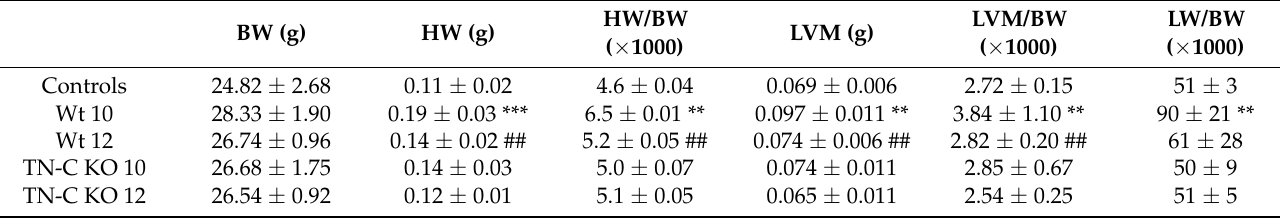
Table 1. Animal characteristics from each group: Controls, Wild-Type 10 weeks (Wt 10), Wild-Type 12 weeks (Wt 12), Tenascin-C knockout 10 weeks (TN-C KO 10), and Tenascin-C knockout 12 weeks (TN-C KO 12) mice.